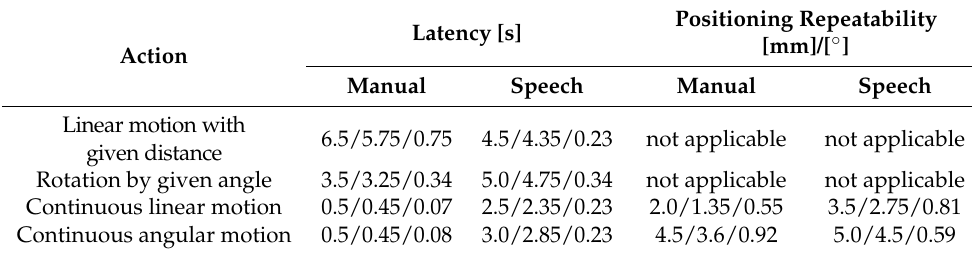
Table 1. Effectiveness of robot actions controlled manually and by